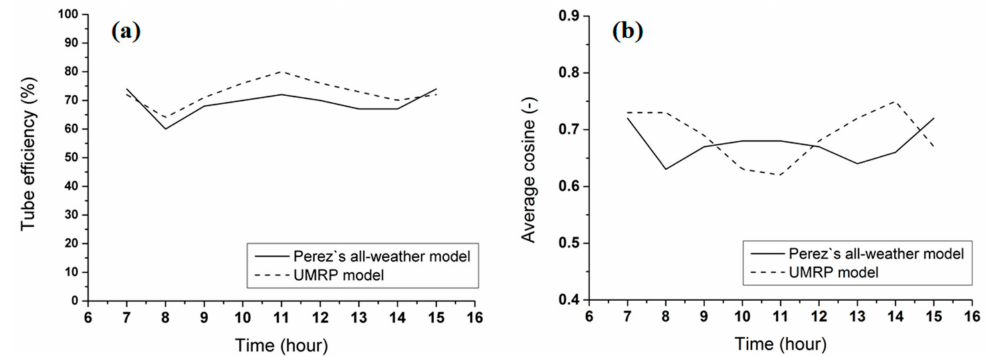
Figure 8. The same as in Figure 6, but for a partly cloudy day, 12 February